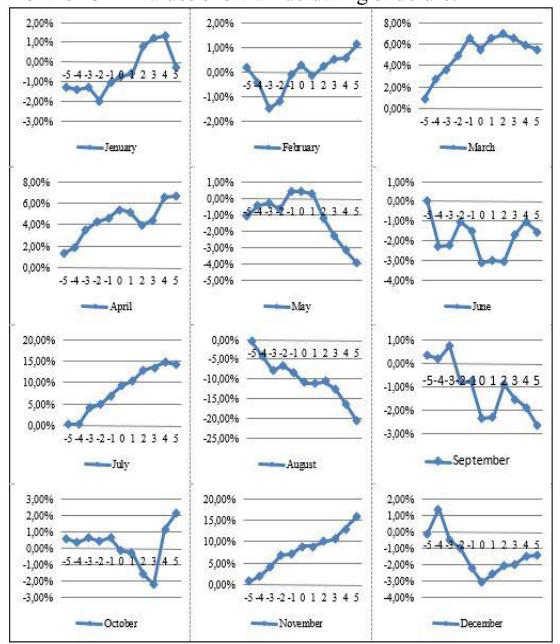
Figure 1. Cumulative Abnormal Returns (CAR) Graphs (2008) Source: Figure complied by authors